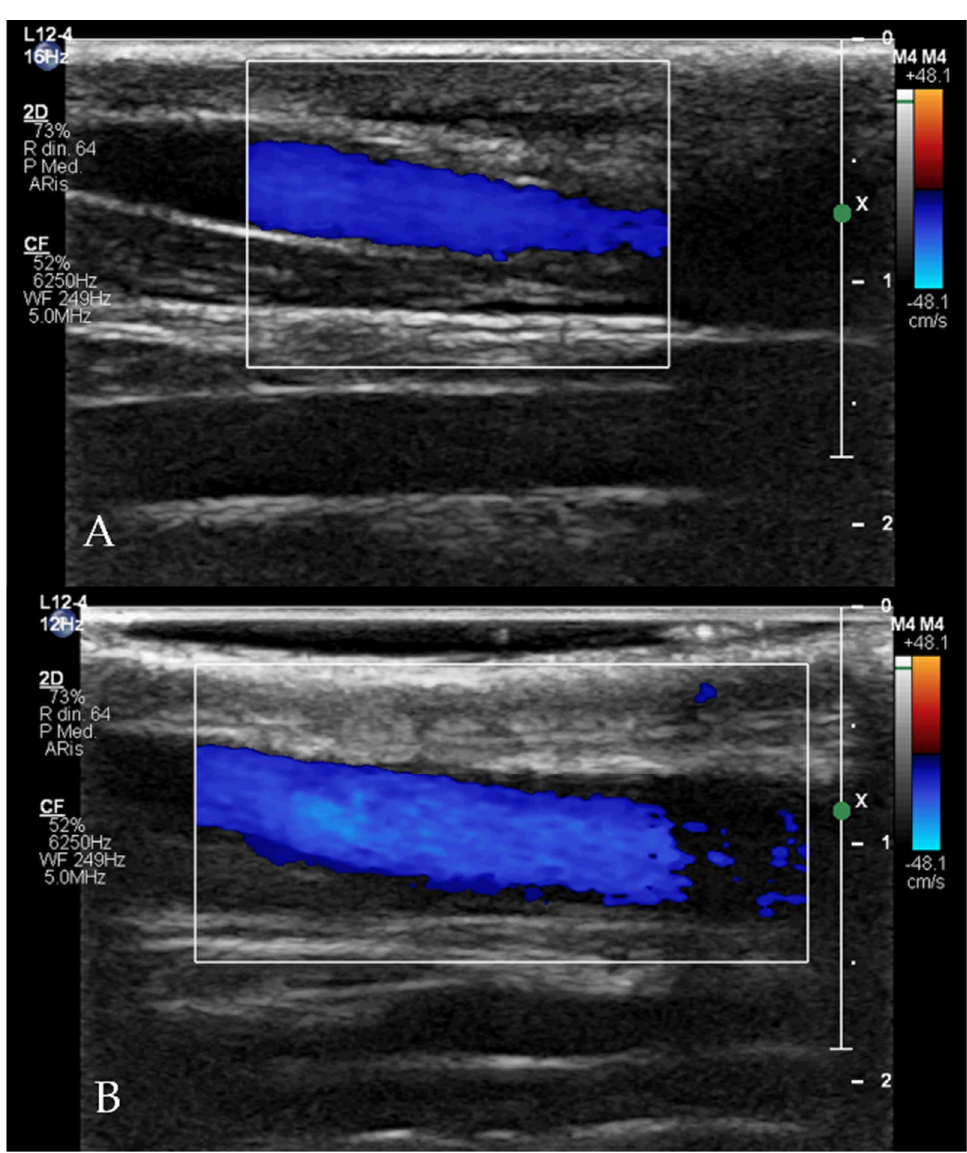
Figure 7. Doppler flow evaluation with linear probe (12 Hz) of the right ( A ) and left ( B ) jugular veins three months after the procedure (Case 5) demonstrating normal size of the right jugular vein com- pared to the left one, and normal flow within the vessel.